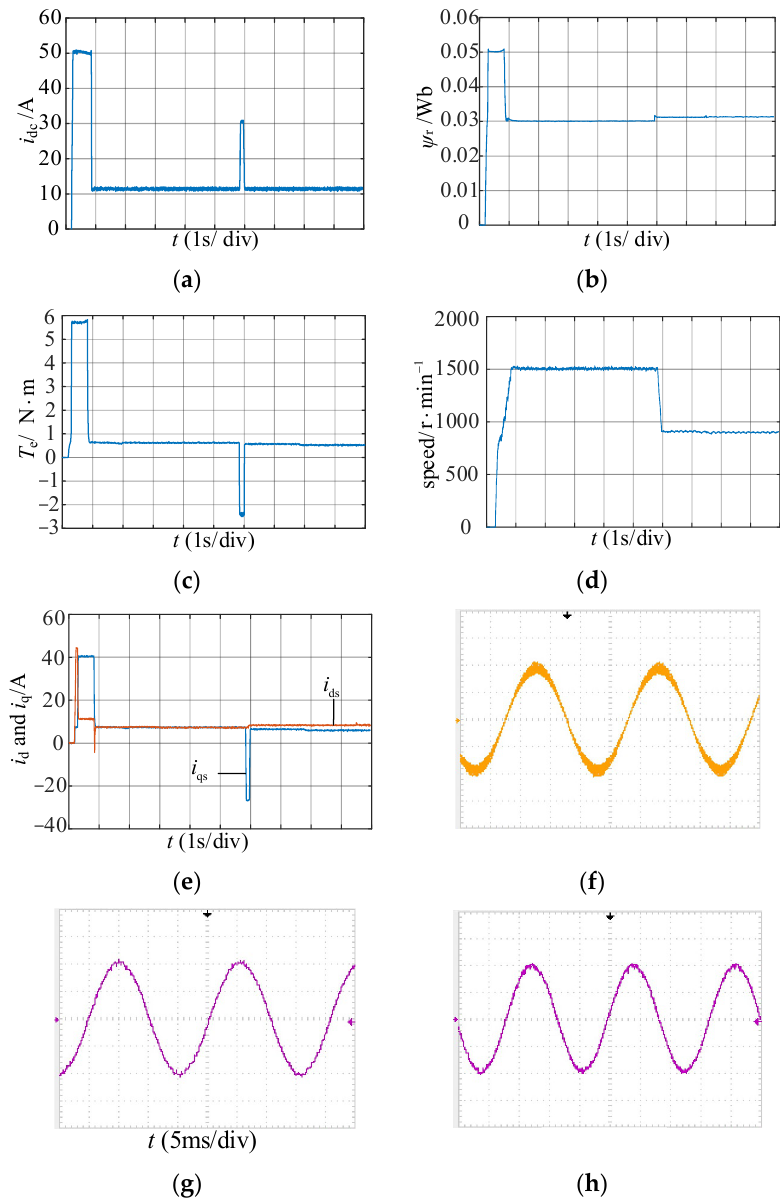
Figure 22. Experimental waveforms under deceleration with no load: ( a ) DC − link current; ( b ) Rotor flux; ( c ) Torque; ( d ) Speed; ( e ) Stator current in d − q axis; ( f ) Stator voltage of phase − a under speed of 900 rpm; ( g ) Stator current of phase − a under speed of 1500 rpm; ( h ) Stator current of phase − a under speed of 900 rpm.